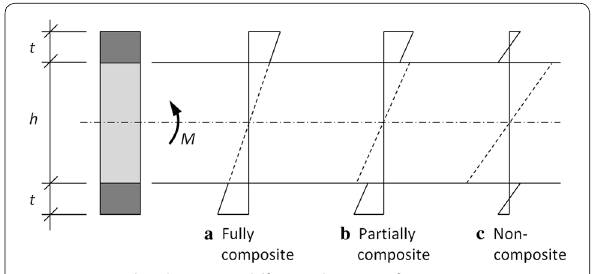
Fig. 9 Strain distribution at different degrees of composite